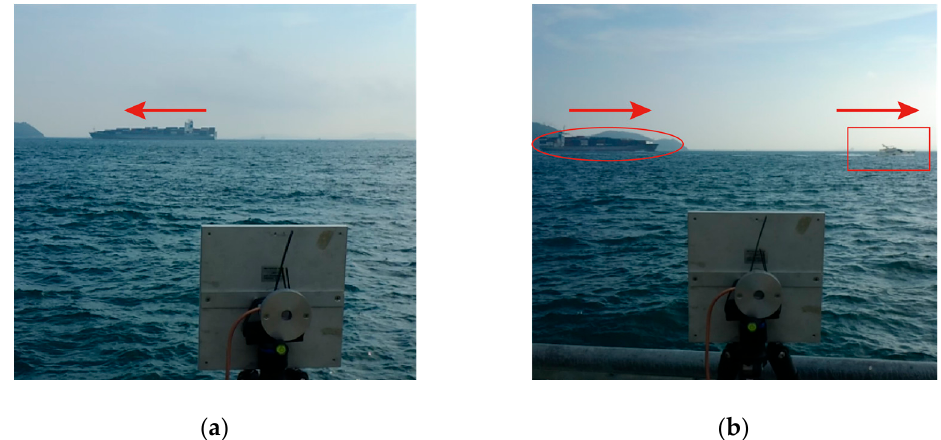
Figure 12. Photographs of two cargo ships: ( a ) is WAN HAI 506 at 16:26, and ( b ) is WAN HAI 313 with a yacht at 16:40.